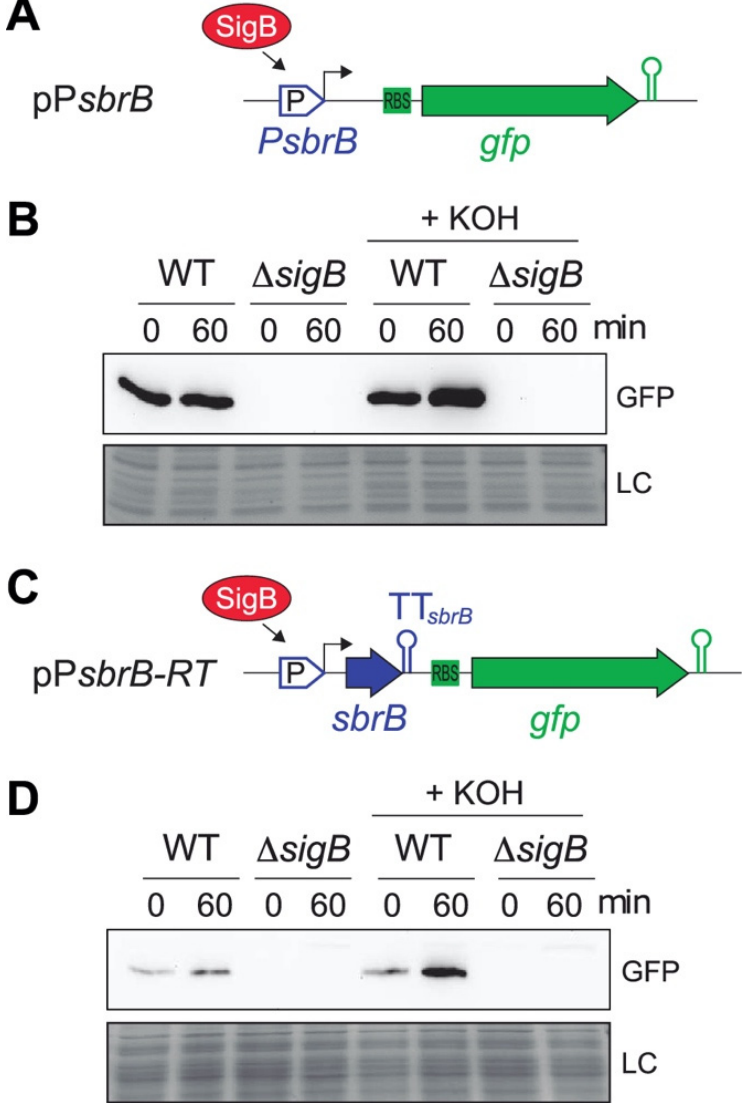
Figure 2. Alkaline stress activates the sbrB promoter and lexA -asRNA expression. Schematic repre- sentations of plasmid constructions including ( A ) the P sbrB transcriptional reporter and ( C ) TT sbrB transcriptional read-through reporter. ( B , D ) Western blots showing the GFP protein levels from the WT and ∆ sigB strain transformed by plasmids illustrated in A and C, respectively. Bacteria were grown until exponential phase and, when necessary, challenged with KOH for 60 min to induce alkaline stress. Proteins were transferred to nitrocellulose membranes, incubated with anti-GFP monoclonal antibodies and developed using peroxidase-conjugated goat anti-mouse antibodies and a bioluminescence kit. Coomassie stain gel portions are included as loading controls.